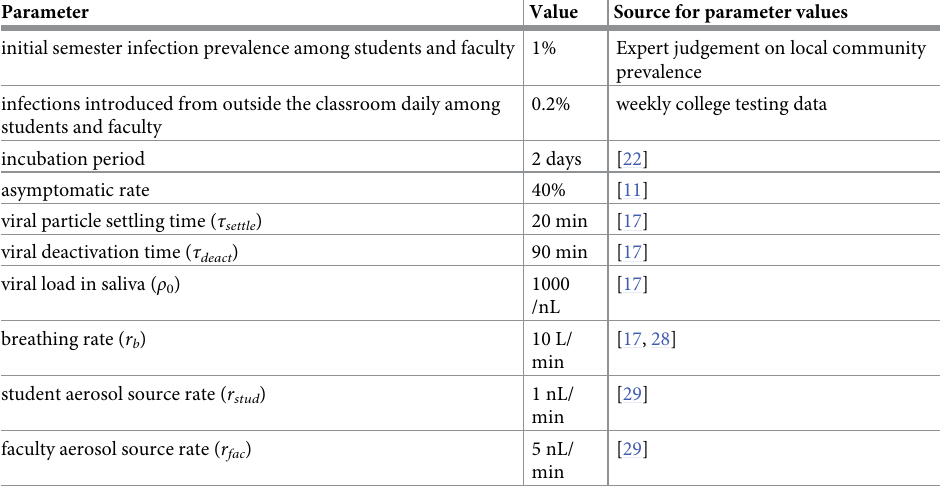
Table 2. User-settable parameters for modeling transmission of and outcomes from COVID-19